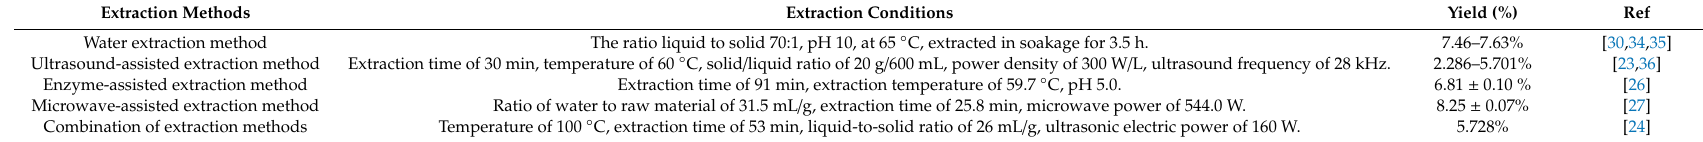
Table 1. Summary of the extraction methods on the extraction of